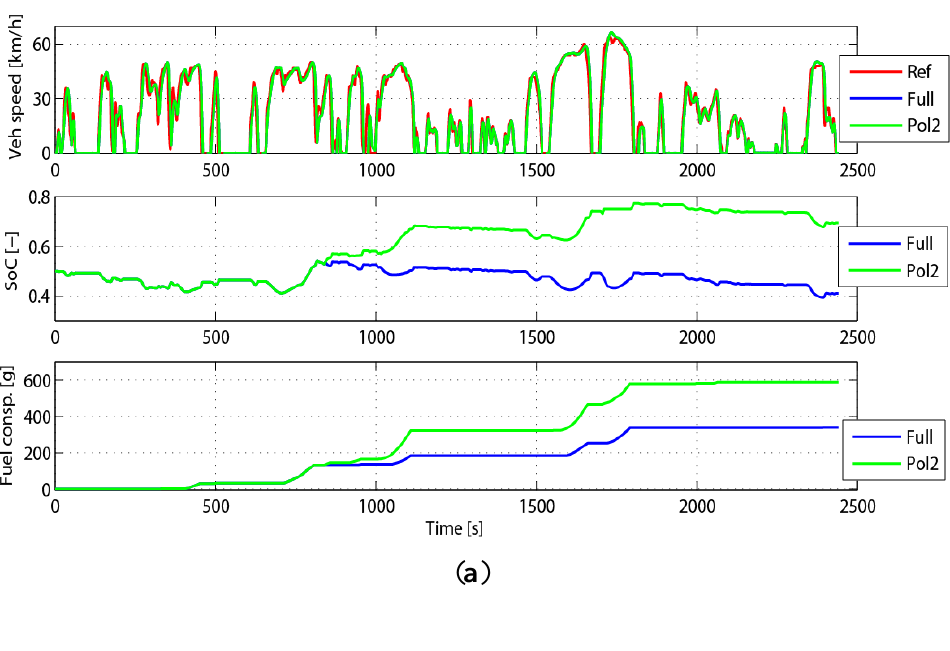
Figure 17. Comparison of the full-policy and a fixing single policy-2 in the first Friday speed profile. ( a ) Vehicle speed, SoC and fuel-electricity consumption; ( b ) engine operating point